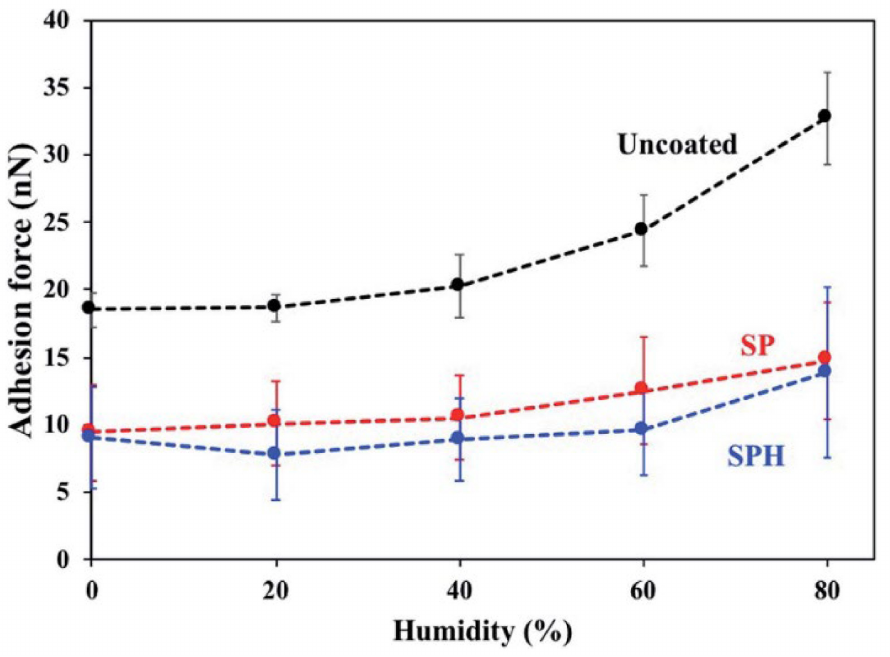
Figure 12. Adhesive force of spherical dust particles with 6 mm diameters on SPH-coated, SP-coated, and uncoated mirrors as a function of relative humidity [62].